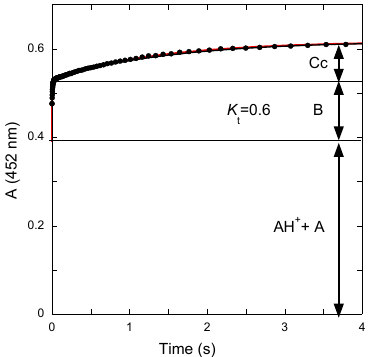
Figure 4. Reverse pH jump from a pseudo-equilibrated solution of P3 at pH = 4.65 (final pH = 1.9). Two kinetic steps are observed, the first one ascribed to dehydration, k obs = 110 s − 1 , and the slowest to ring closure, k − t = 0.6 s − 1 .